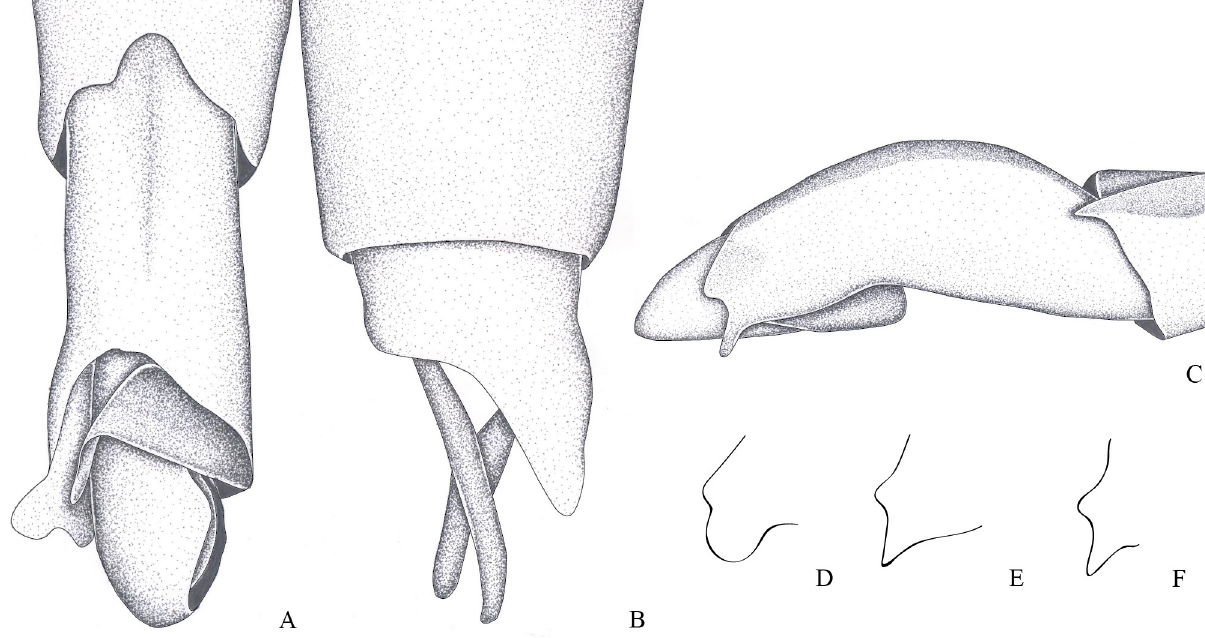
Fig 19. Potamboates woytkowskii . (A) Male, terminalia, ventral view; (B) female, terminalia, ventral view; (D) male, terminalia, left lateral view; (F) male, terminalia, right lateral virw; (G) phallus, lateral view; (H) junction between dorsal and ventral sclerite; (I) base of ventral sclerite; (J) proctiger, dorsal